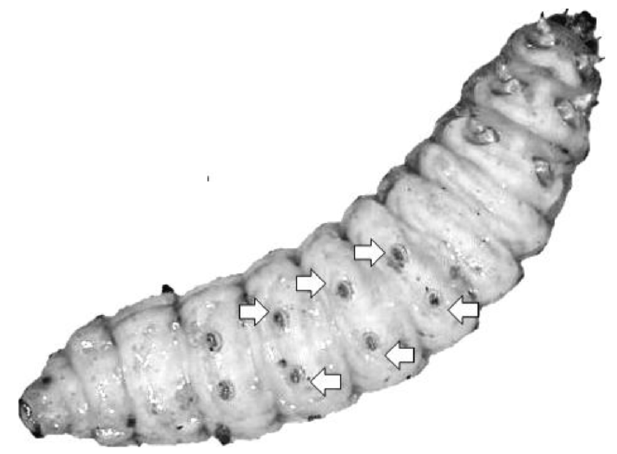
Figure 1. View of a single G. mellonella larva from the underside, showing the six frontal prolegs (arrowed) which are the preferred sites for